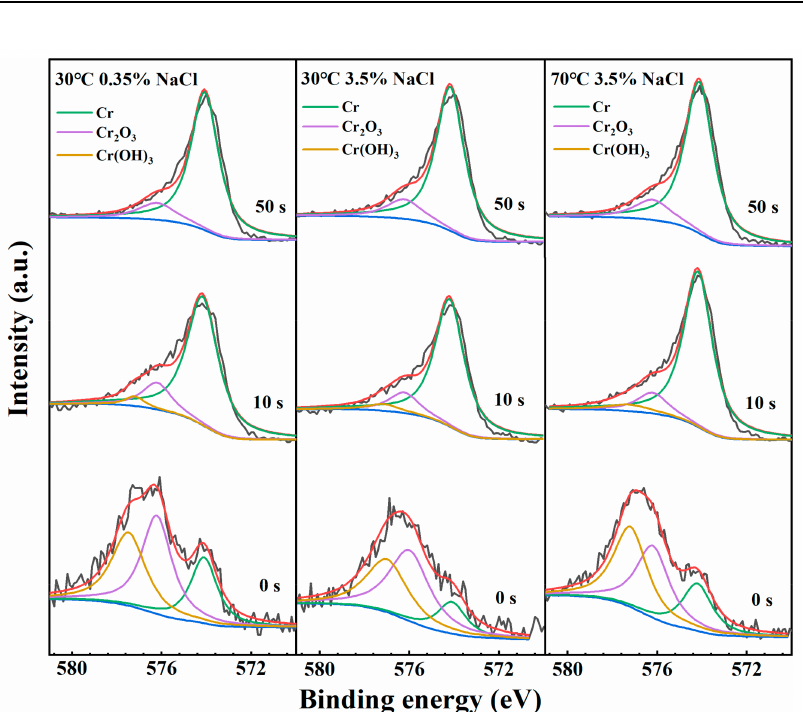
Figure 9. The detailed XPS spectra of Cr 2p 3/2 in the film on the Fe-based AMCs with different sputtering times in the NaCl solution with various concentration and